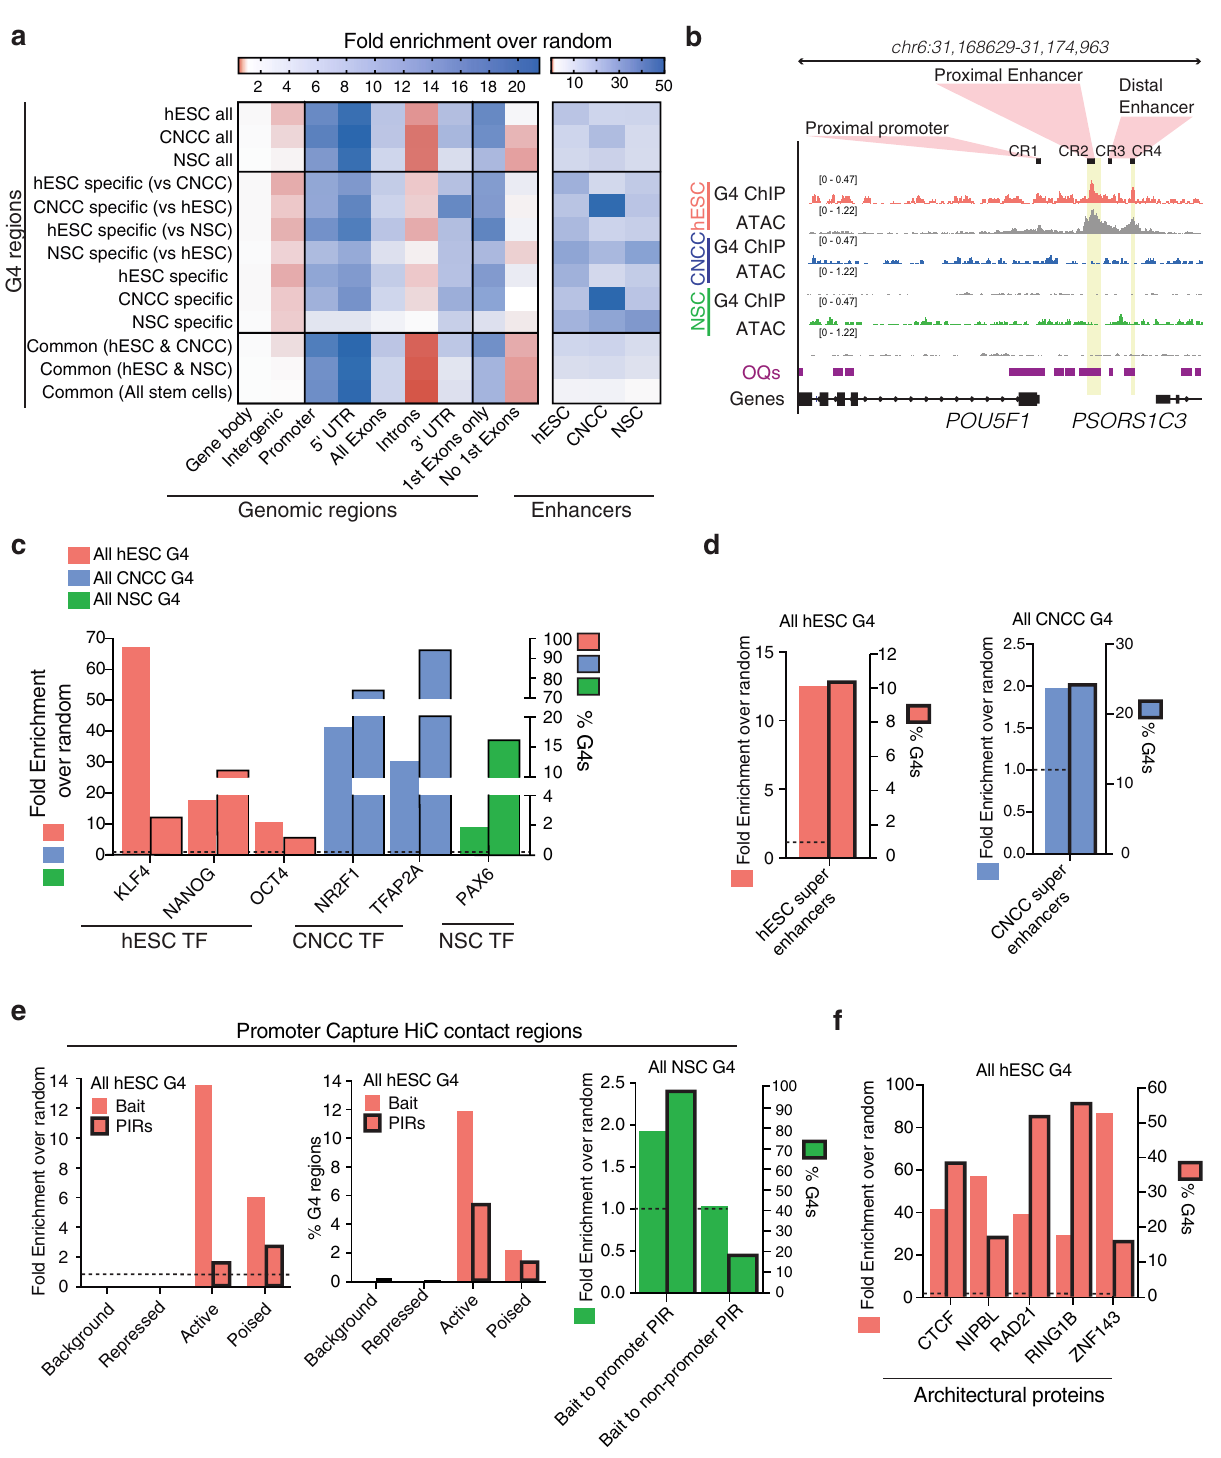
Fig. 2 G4s are found in stem cell regulatory elements. a Fold enrichment over random ( n = 1000 permutations) for G4s at genomic features from the reference human annotation GENECODE v.28 or at enhancers, de fi ned as promoter distal H3K27ac. UTR untranslated region; Promoter de fi ned as ±1 kb around transcription start site. b Genome browser view of G4 signal across hESC-speci fi c proximal and distal enhancer of POU5F1 (as de fi ned in Yang et al. 89 ). CR conserved region. The yellow box highlights regions where G4s overlaps open chromatin (ATAC) and genome sites which have the ability to fold into G4 structures in vitro (OQs 13 ). c – f Fold-enrichments over random ( n = 1000 permutations) and proportion of G4s per stem cell type at c the binding sites of cell-speci fi c transcription factors (TF); d super-enhancer elements as de fi ned in Hnisz et al. 34 and Wilderman et al. 90 ; e promoter (bait) and promoter-interacting regions (PIRs) from promoter-capture HiC experiments (as de fi ned in Freire-Pritchett et al. 40 . Centre and left panel: hESCs active promoters (H3K4me3 and/or H3K27ac), poised promoters (H3K4me3 and H3K27me3), repressed promoters (H3K27me3) and background (none). Right-most panel: NSC promoter-promoter PIRs and promoter-non-promoter PIR interactions of developmentally analogous H1-hESC-derived neural progenitor cells from Jung et al. 41 ; f binding sites of chromatin architecture proteins involved in promoter-enhancer looping. NATURE COMMUNICATIONS| (2022) 13:142